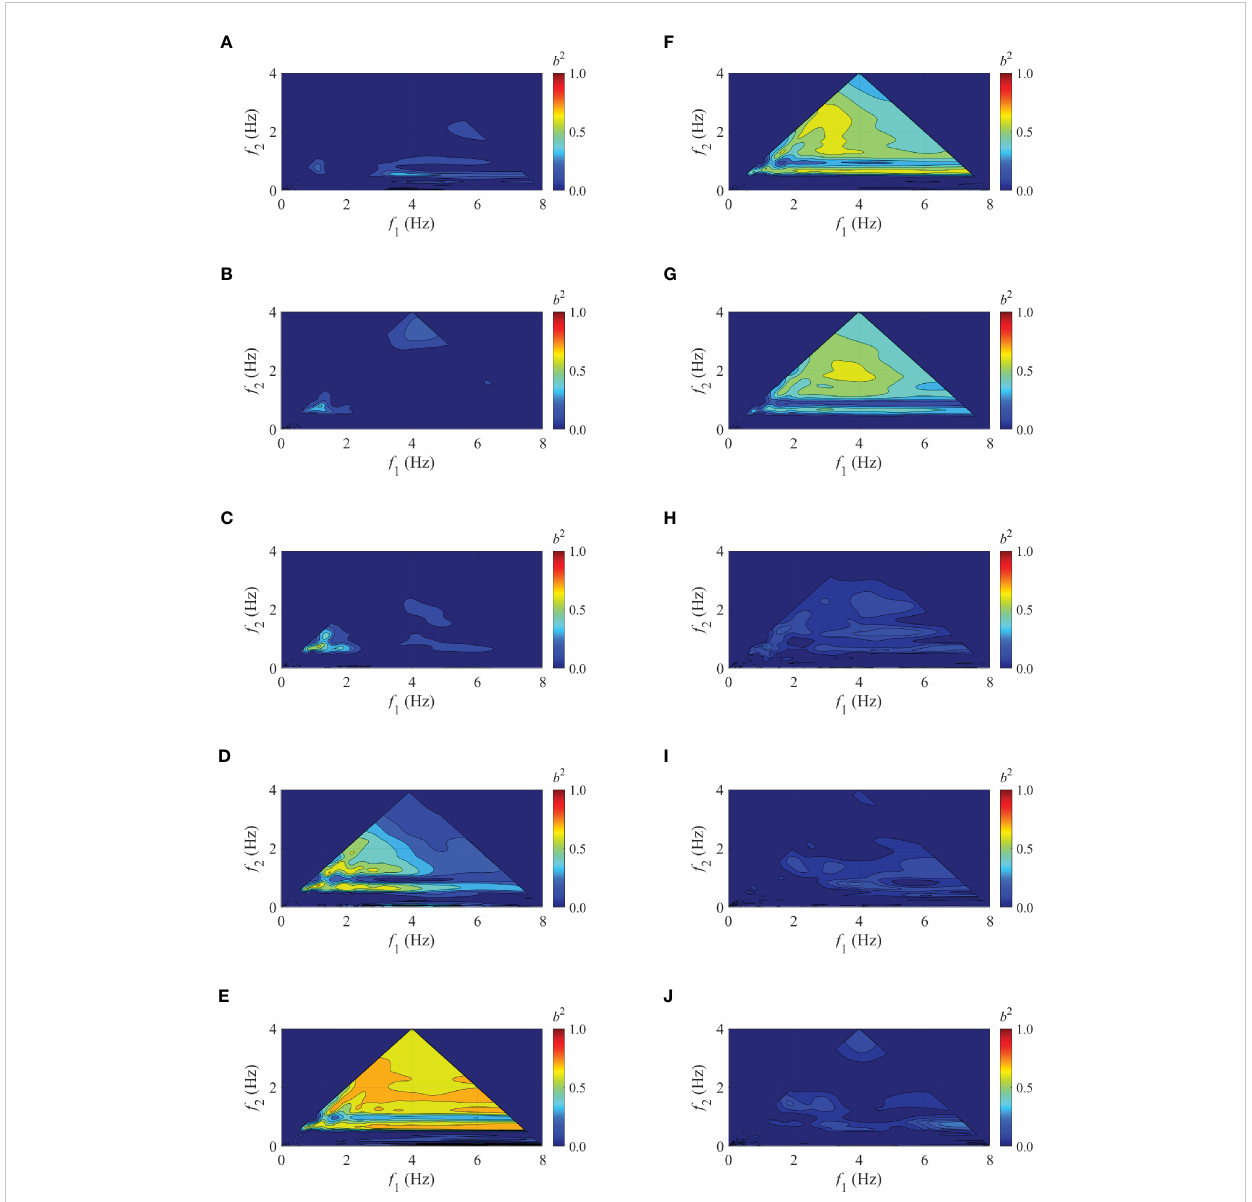
FIGURE 11 Evolutions of the wavelet-based bicoherence for the case RJ 7 at stations: (A) 2 # ; (B) 4 # ; (C) 6 # ; (D) 7 # ; (E) 8 # ; (F) 9 # ; (G) 10 # ; (H) 11 # ; (I) 14 # and (J) 17 # ; the freak wave occurs at station 7 #